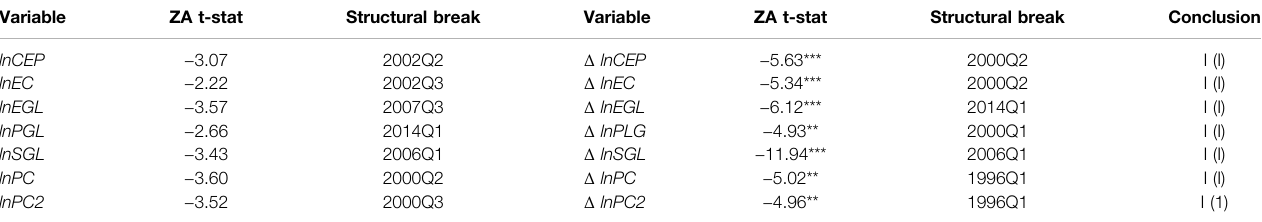
TABLE 5 | Unit root results with structural break.